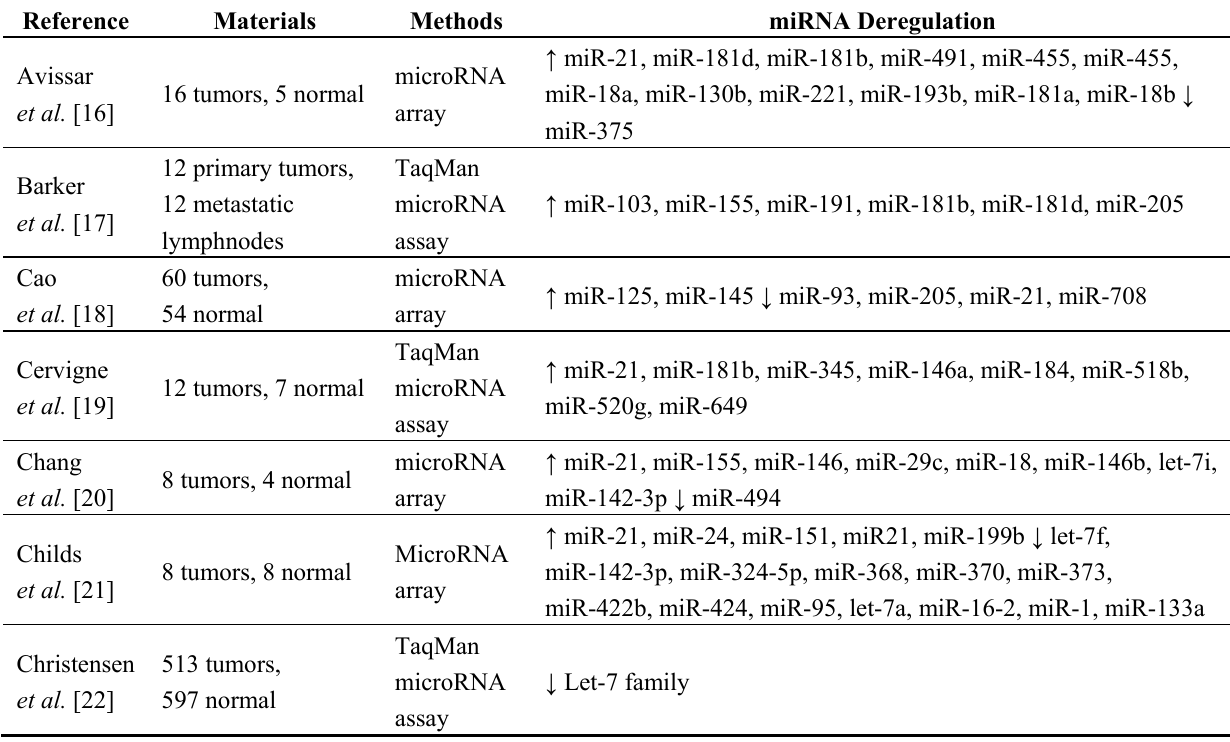
Table 1. miRNA expression profiling in SCHNC recent